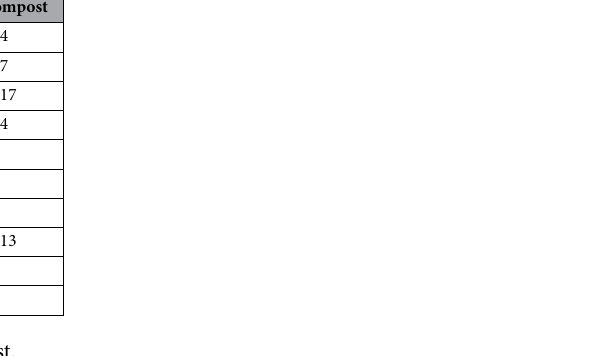
Table 1. Properties of the MSW